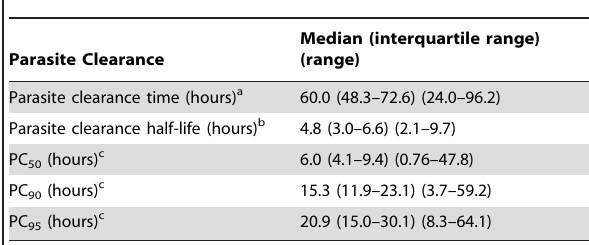
Figure 3. Cumulative proportion of participants developing recurrent P.falciparum or/and P.vivax infection after comple- tion of artesunate monotherapy.